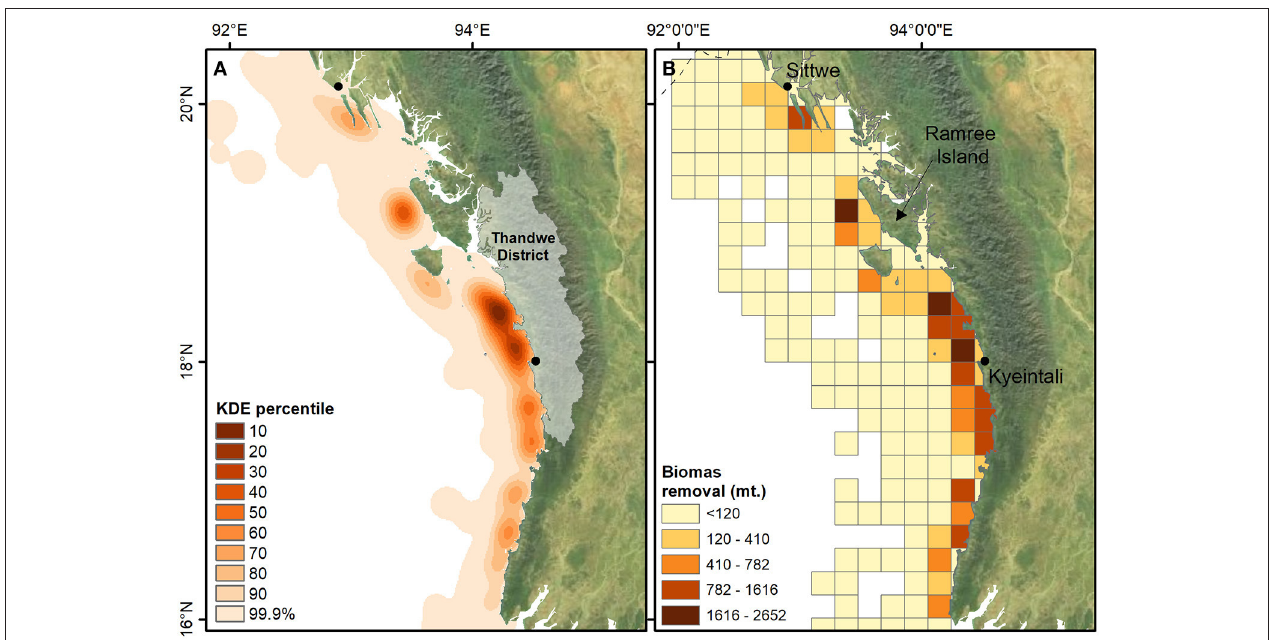
FIGURE 6 | Regional annual spatial fishing effort and biomass removal. (A) Kernel density estimate (KDE) of total VBD detections (01/10/2016 – 31/05/2019) in the North of Myanmar, to highlight regional hotspots of fishing effort. KDE using a 1 × 1km grid cell and a 20km search radius and (B) spatial biomass yield estimates using a cumulative sum of monthly estimates at a 20 × 20km grid cell resolution. Key locations discussed in the text highlighted. Intervals as displayed using a Natural Breaks (Jenks) function generated in ArcMap 10.6.1. Note the KDE symbology excludes the final 0.1% of data to improve visibility of